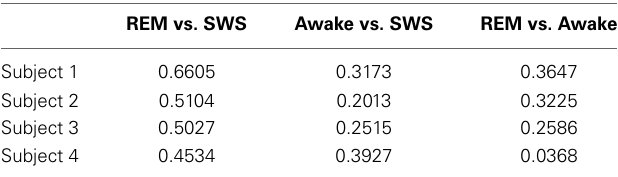
Table 1 | Effect size (Cohen’s